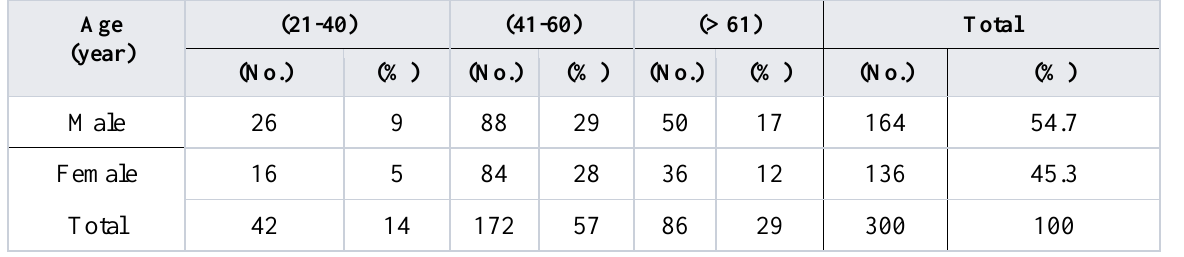
Table (1): The distribution of age and gender in the selected patient